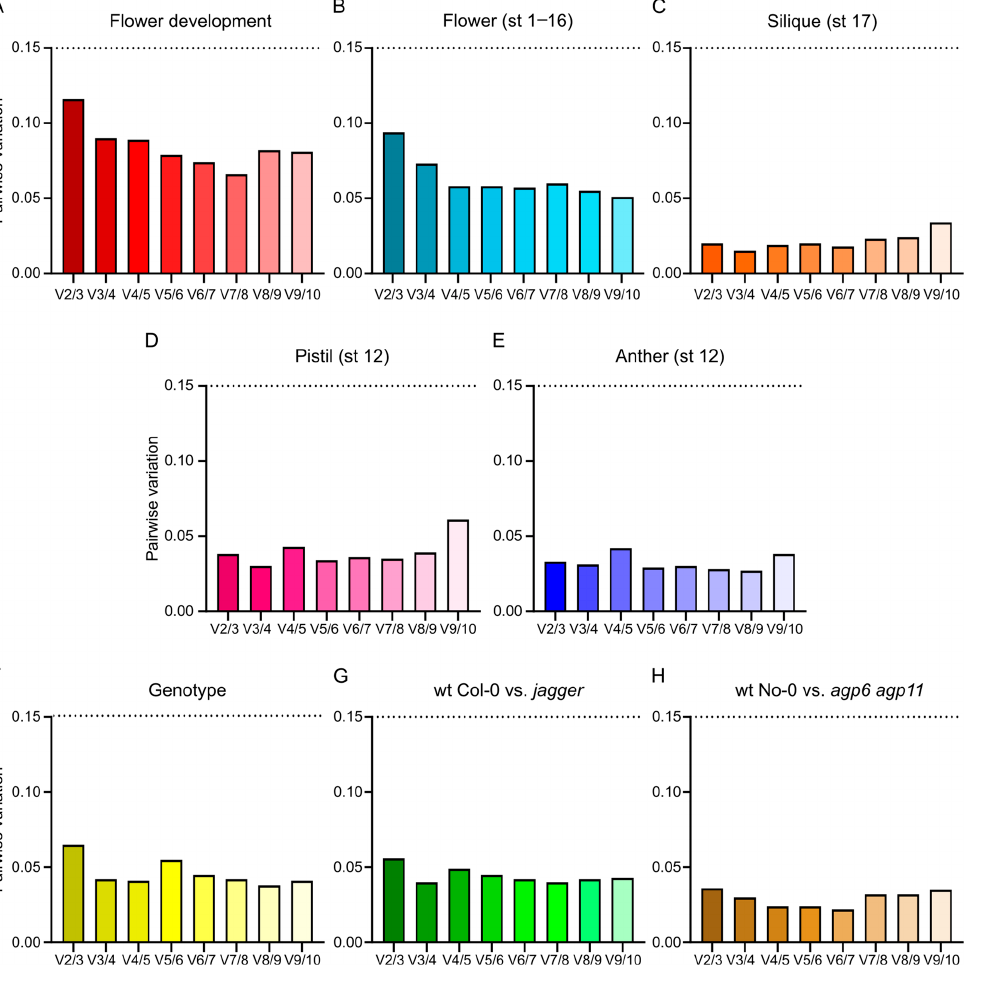
Figure 3. Pairwise variation (Vn/Vn+1) of the ten candidate reference genes using geNorm. ( A ) Pair- wise variation values of the ten candidate reference genes in the flower development group which included 21 samples corresponding to flower (st 1–16), silique (st 17), pistil (st 12), and anther (st 12) samples. ( B ) Pairwise variation values of the ten candidate reference genes in 12 flower (st 1–16) samples which included flower st 1–6, flower st 7–12, flower st 13–14, and flower st 15–16 samples. ( C ) Pairwise variation values of the ten candidate reference genes in the three silique (st 17) samples. ( D ) Pairwise variation values of the ten candidate reference genes in the three pistil (st 12) samples. ( E ) Pairwise variation values of the ten candidate reference genes in the three anther (st 12) samples. ( F ) Pairwise variation values of the ten candidate reference genes in the genotype set that comprised 12 samples corresponding to wt Col-0, jagger , wt No-0 and agp6 agp11 samples. ( G ) Pairwise varia- tion values of the ten candidate reference genes in six wt Col-0 vs. jagger samples that included three wt Col-0 and three jagger samples. ( H ) Pairwise variation values of the ten candidate reference genes in six wt No-0 vs. agp6 agp11 samples which included three wt No-0 and three agp6 agp11 samples. The pointed line represents the cut-off value of 0.15. Abbreviations: Col-0, Columbia-0; No-0, Nos- sen-0; st, stage; wt, wild-type.